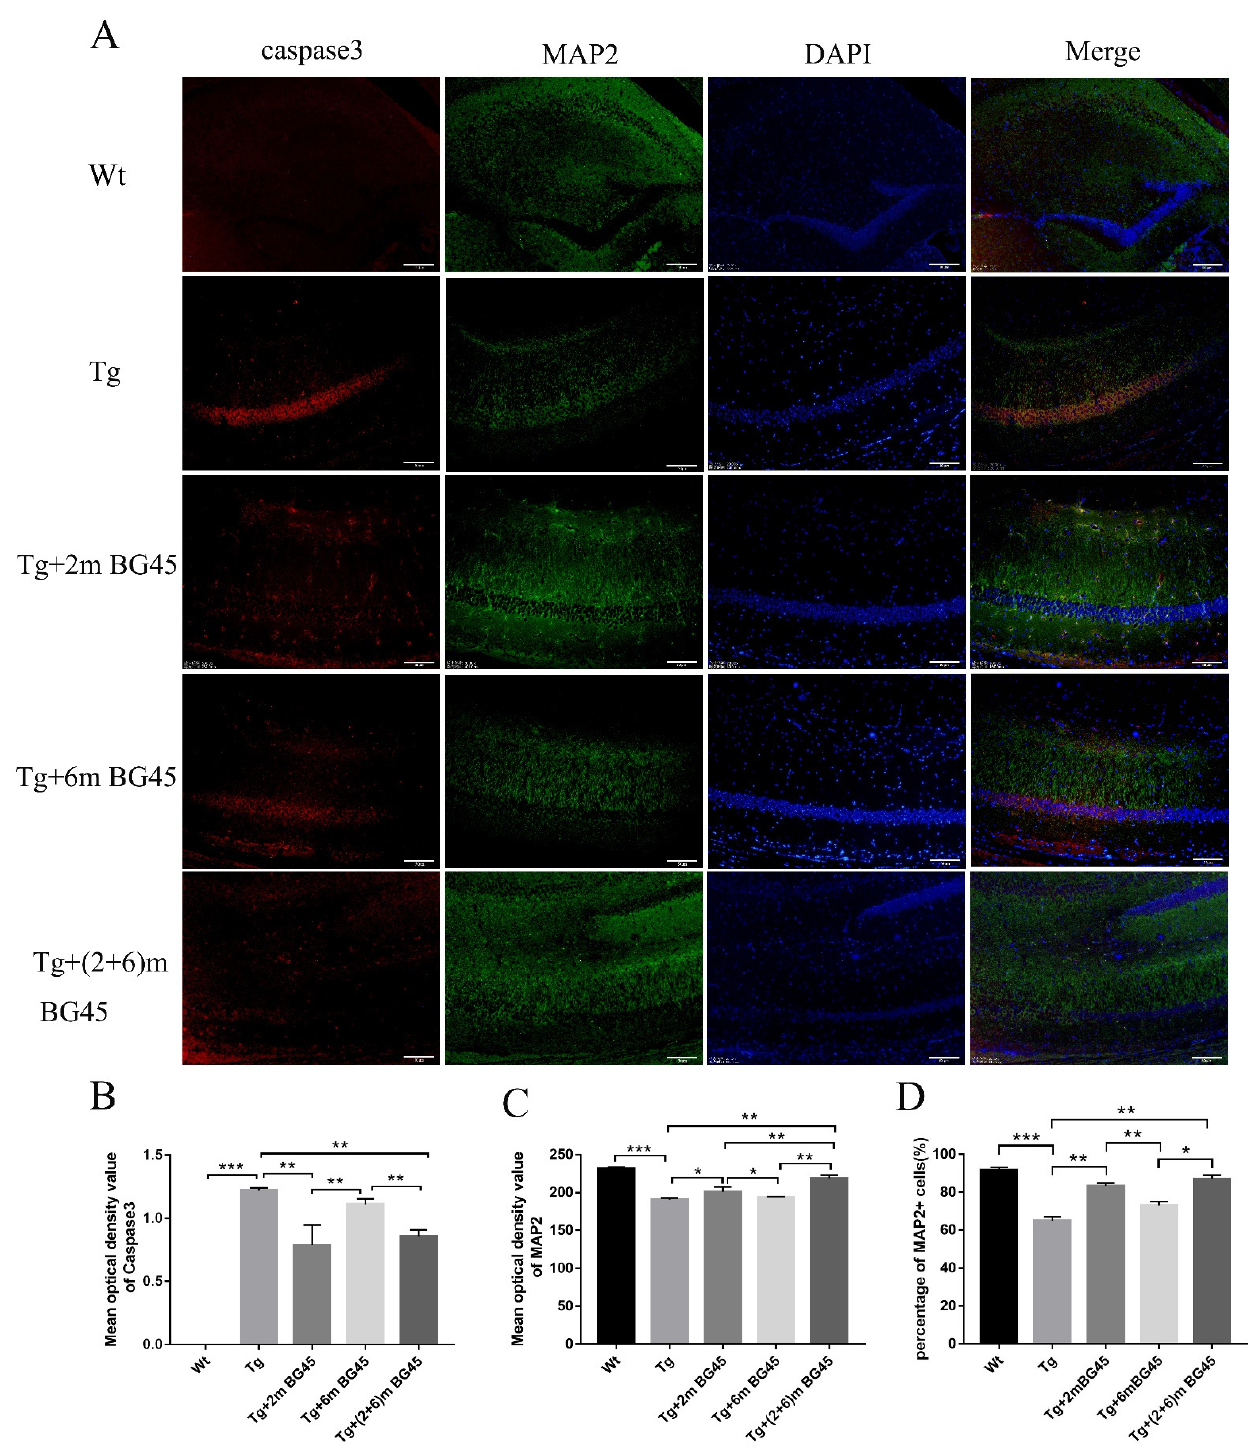
Figure 7. Protective effect of BG45 on hippocampal neurons in APP/PS1 transgenic mice ( n = 5). ( A ) Immunofluorescence staining for the caspase-3 and MAP2 proteins in hippocampal neurons from animals treated with vehicle or BG45. ( B ) Quantification of the caspase-3 protein levels. ( C ) Quantifi- cation of the MAP2 protein levels. ( D ) Percentage of MAP2+ cells. Scale bar = 50 µ m ( A ). Significant differences were determined using one-way ANOVA. All values are presented as the means ± SD from three independent experiments. * p < 0.05, ** p < 0.01, and *** p < 0.001, n = 5 mice per group.